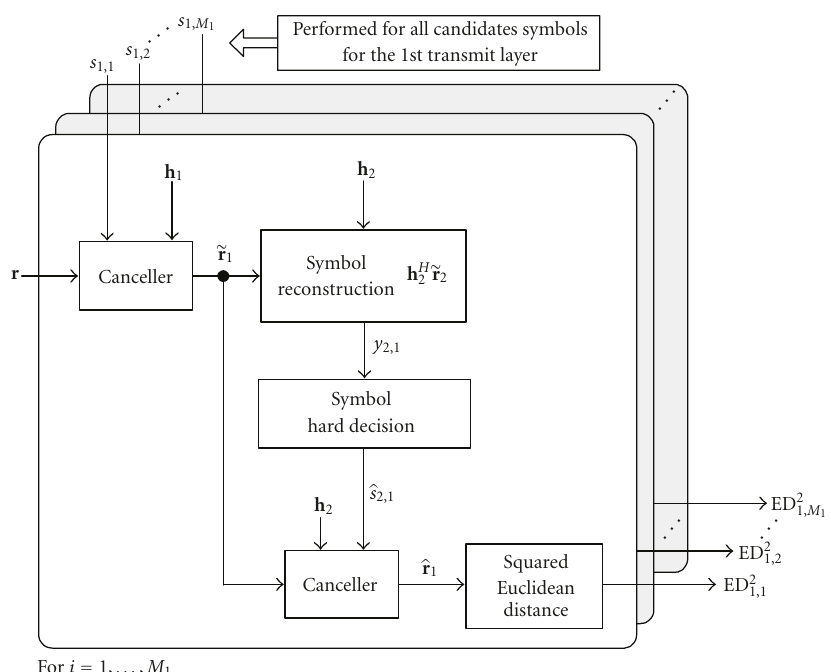
Figure 5: Block diagram of the proposed decoding scheme II for the first transmit